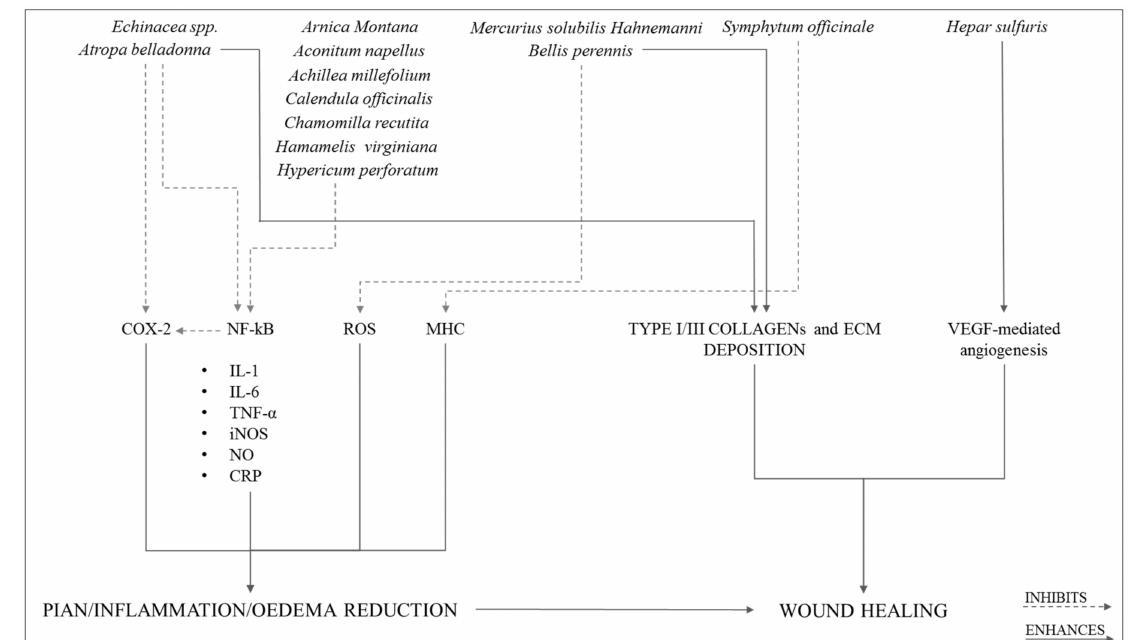
Figure 4. Synoptic diagram of the biological actions performed by each component of Tr14.